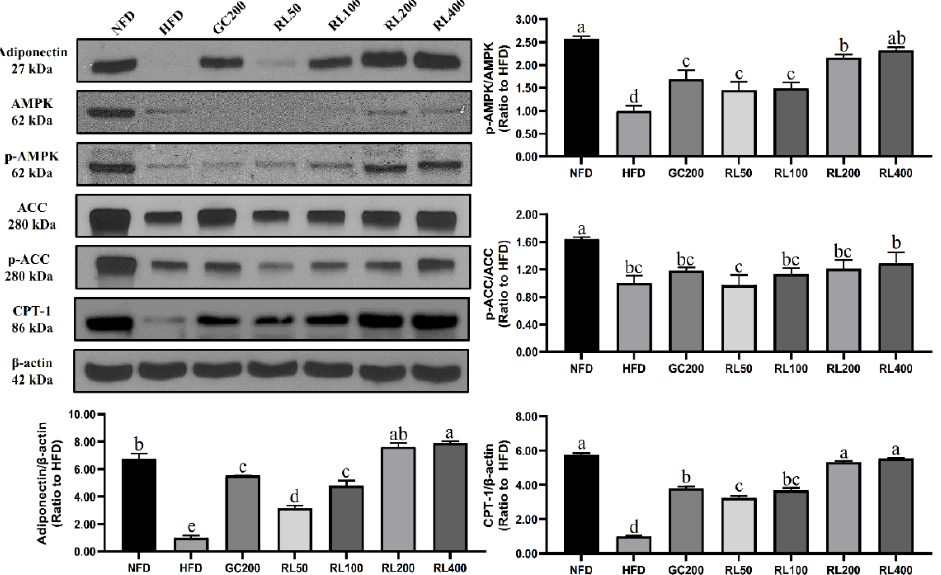
Figure 6. Effects of RL at various concentrations on energy metabolism-related proteins in epididymal adipose tissue of high-fat-diet-induced obese C57BL/6J mice. Values presented as mean ± SD of experiments ( n = 3). RL—red ginseng and licorice extracts mixed at a 3:1 mass ratio; NFD—mice fed normal-fat diet (10% kcal fat); HFD—mice fed high-fat diet (60% kcal fat); GC200—HFD + 200